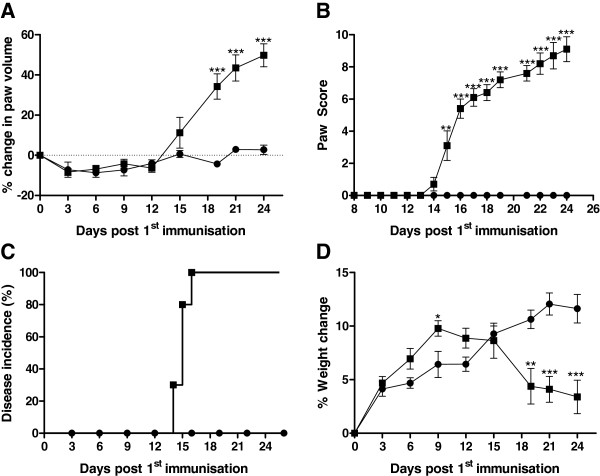
The percentage increase in paw volume (A), paw score (B), percentage disease incidence (C), and percent weight changes (D) observed post 1st immunization. The CIA group (squares, n = 10) and control animals (circles, n = 10) were compared by Mann–Whitney t-test. All statistical analyses were calculated based on baseline corrected values. Data are shown as mean ± SEM and significance levels as *: P < 0.05, **: P < 0.01, ***: P < 0.001.